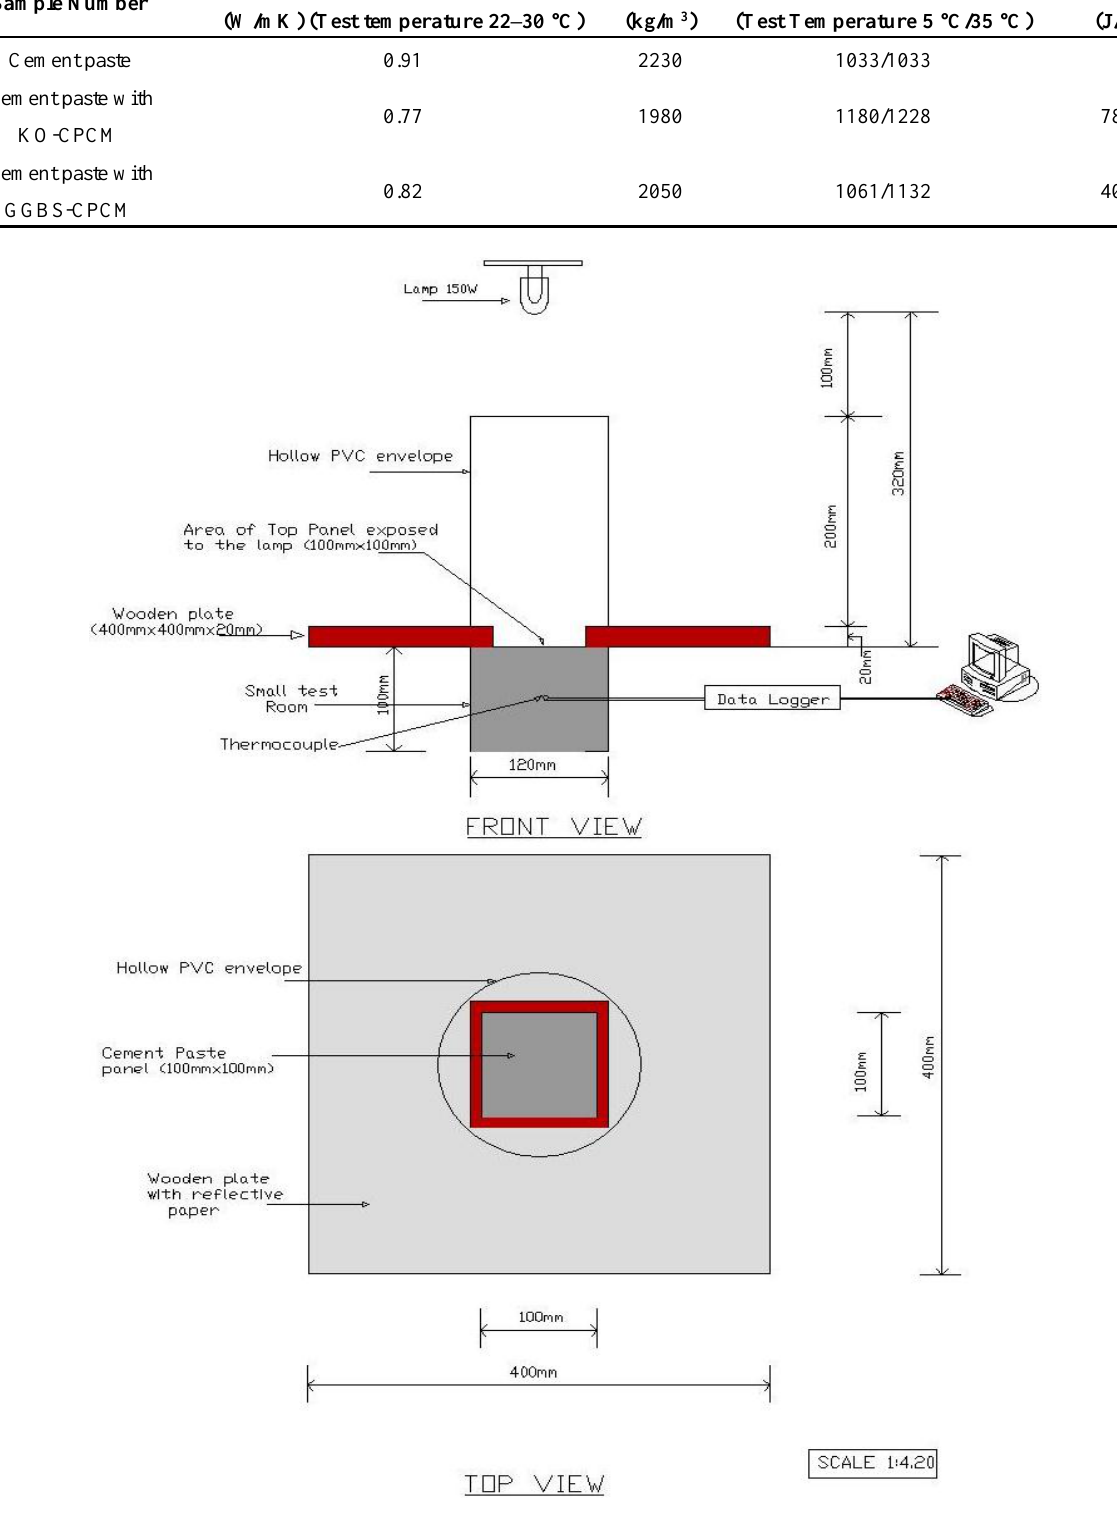
Figure 2. Schematic of thermal performance